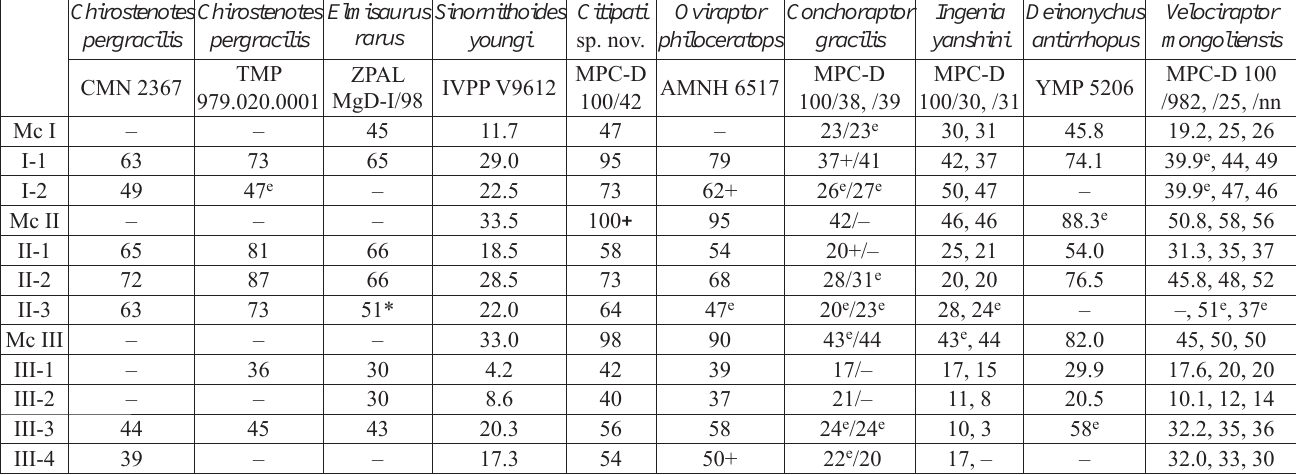
Table 2. Manus measurements (in mm) of some maniraptorans. e , estimate; Mc, metacarpal; nn, unnumbered specimen; *, considered earlier (Osmólska 1981) as I-2.